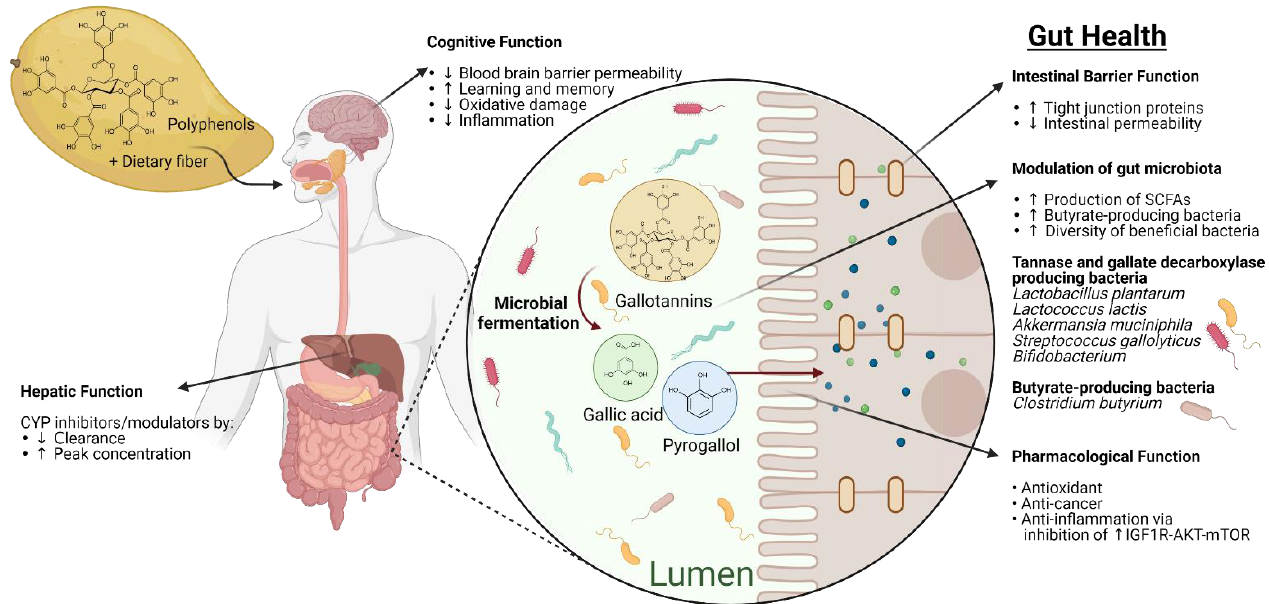
Figure 1. Overview of the proposed mechanism of actions of mango polyphenols and fiber consumption on human intestinal health. Mango polyphenols and fiber may promote gut health through their pharmacological activities, modulation of beneficial gut microbiota (tannase, gallate decarboxylase, and butyrate-producing bacteria) and thus, contribute to maintaining the gut barrier and cognitive function. Created using BioRender (https://biorender.com/) as part of Academic License.